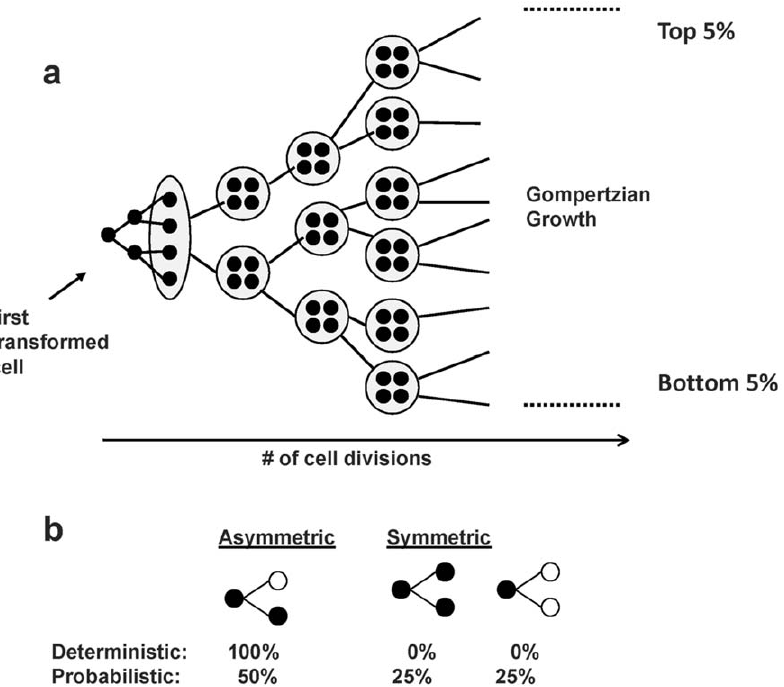
Figure 7. Schematic of sample genealogy. (a) Example genealogy. Black circles denote cancer stem cells and grey circles denote cancer glands. (b) Two models for cell division. Black circles denote CSCs and white circles denote non-CSCs.